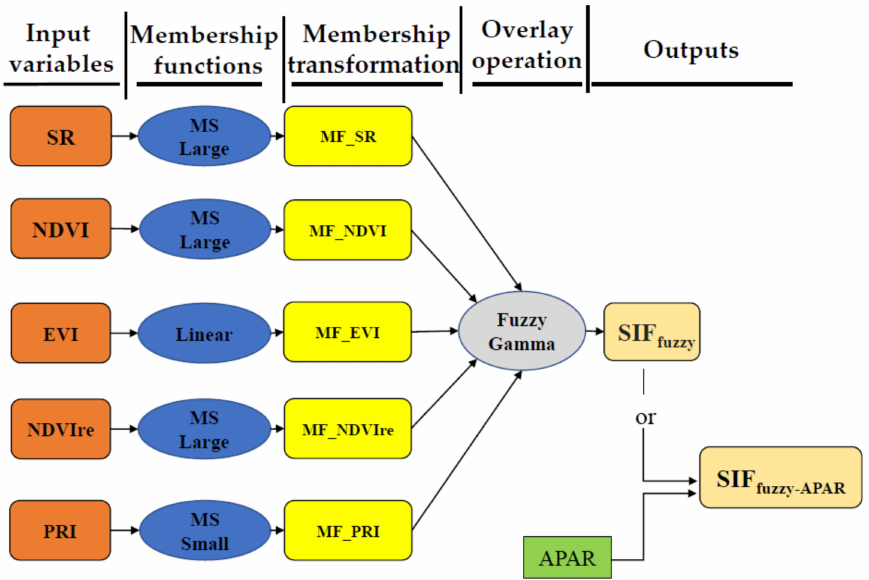
Figure 4. Schema of the fuzzy logic modelling system adopted in this study showing the progress from the input variable to the membership transformation in order to overlay operation to the final